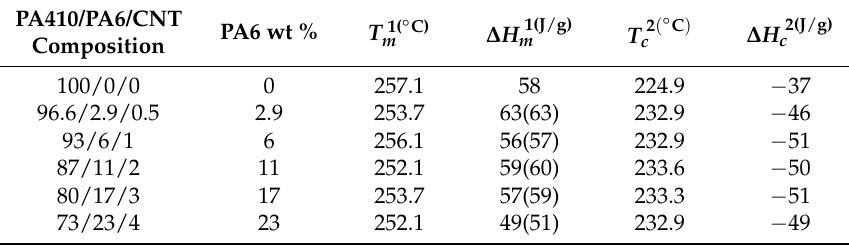
Table 4. Calorimetric parameters of PA410/PA6/CNT